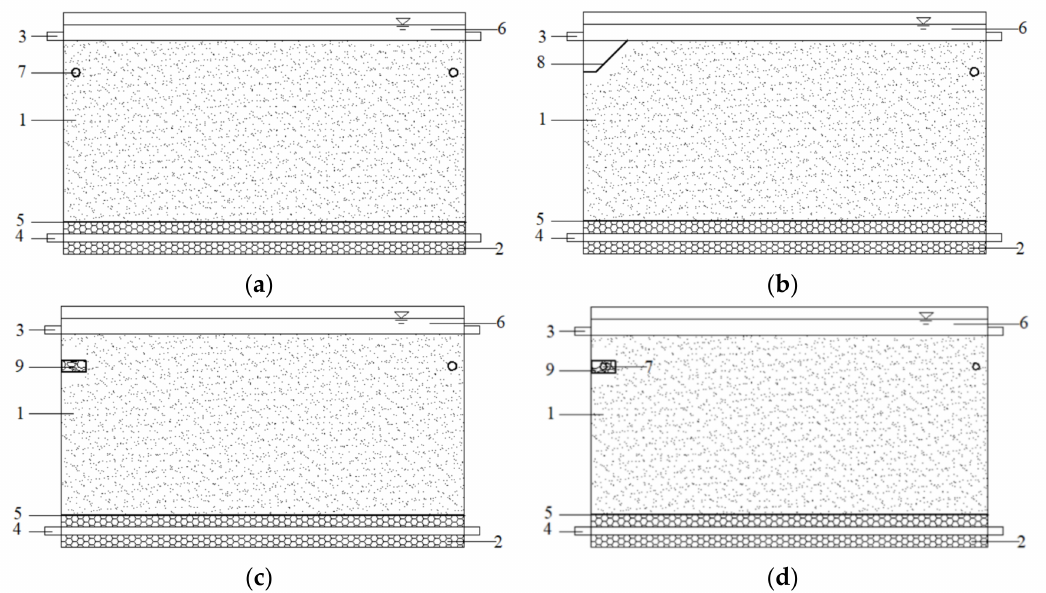
Figure 3. Structural planar graph of different combined drainage forms, ( a ) Conventional subsurface drainage, ( b ) Open- ditch and conventional subsurface drainage, ( c ) Filter and conventional subsurface drainage, ( d ) Improved and conventional subsurface drainage; Unit: mm. 1. Soil medium (80–120 mesh quartz sand); 2. Highly permeable materials (2–4 mm- diameter quartz sand); 3–4 Charging pipe; 5. Gauze; 6. Ponding water; 7. Conventional subsurface pipe; 8. Open ditch; 9. Filter